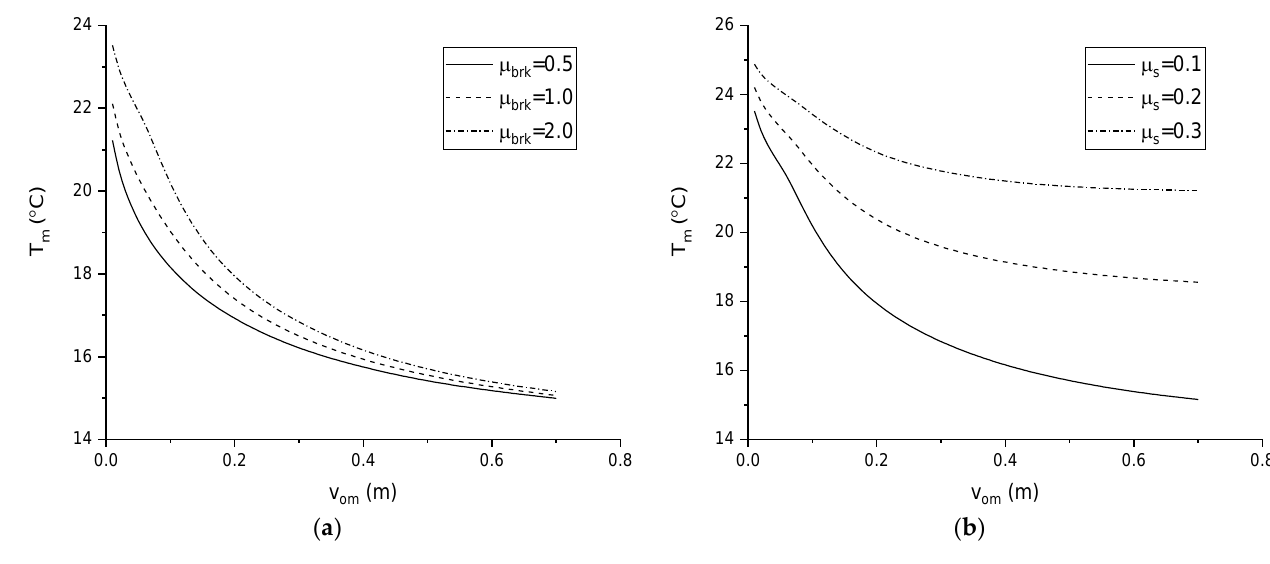
Figure 12. ( a ) Influence of 𝑣 𝑜𝑚 on 𝑇 𝑚 with different 𝜇 𝑏𝑟𝑘 ( 𝜇 𝑠 = 0.1 ). ( b ) Influence of 𝑣 𝑜𝑚 on 𝑇 𝑚 with different 𝜇 𝑠 ( 𝜇 𝑏𝑟𝑘 = 2.0 ).